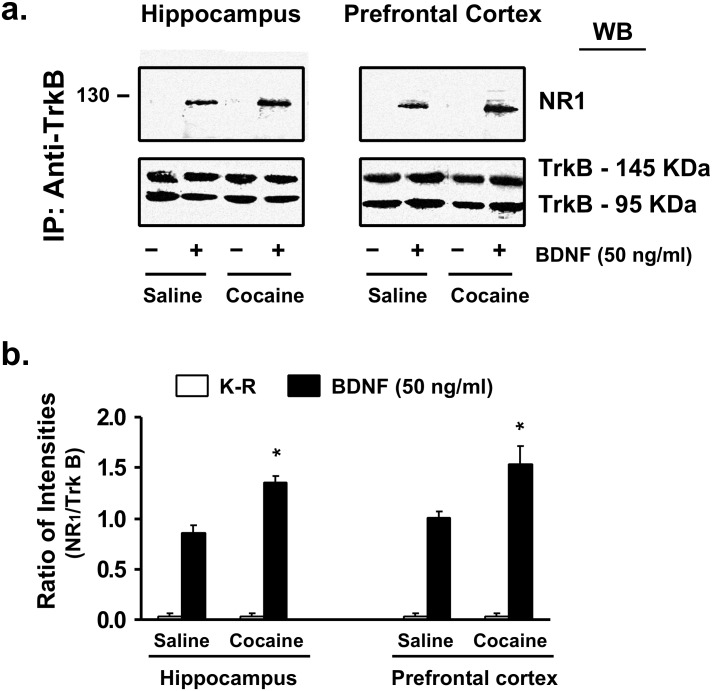
Prenatal cocaine exposure heightened TrkB-NMDAR interaction in hippocampi and PFCX.Prenatal cocaine exposure heightened TrkB-NMDAR interaction in hippocampi and PFCX as indicated by the Western blot detection of increased level of obligatory subunit of the NMDARs, NR1 in the anti-TrkB immunoprecipitates (top). Western blots were analyzed by densitometric quantification. The data are expressed as the ratios of NR1 optical intensity normalized by the optical intensity of total 145-KDa TrkB. n = 6 (3 males and 3 females). Data are means ± s.e.m. of the ratios of NR1 to 145-KDa TrkB optical intensities. *p < 0.01, compared to respective protein in the saline-treated group.